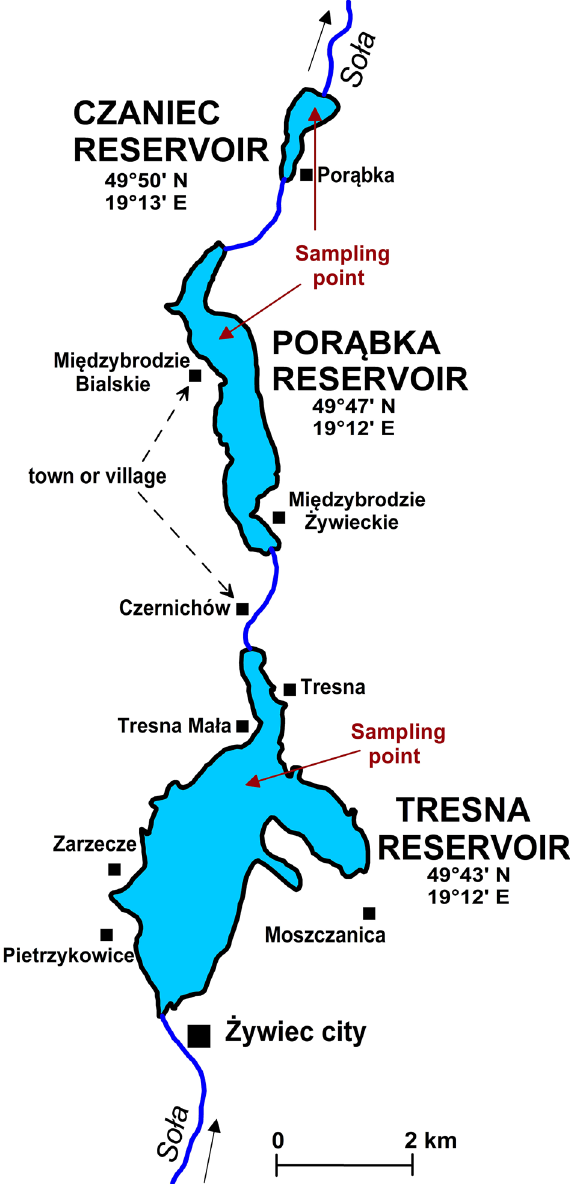
Figure 2. Soła River dam cascade—situational sketch with sampling